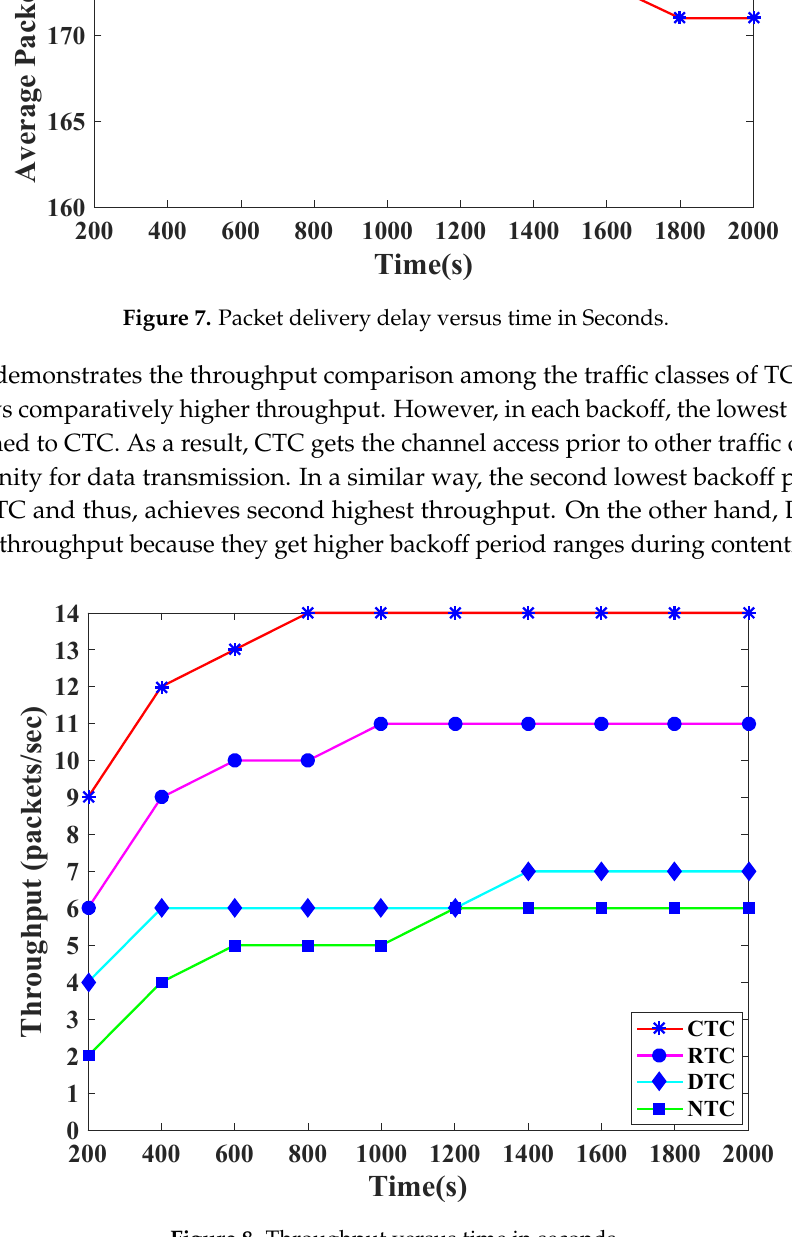
Figure 8. Throughput versus time in seconds.